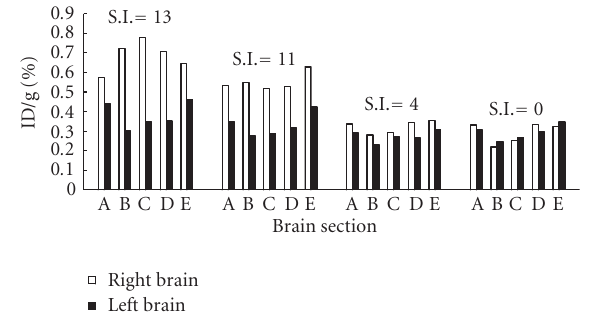
Figure 2: The uptake of [ 131 I]2NPBTA in coronal brain slices (des- ignated A, B, C, D, E from rostral to caudal ends) from 4 gerbils subjected to right common carotid ligation after repetitive admin- istration. The coronal slices stroke index (SI) was indicated above the